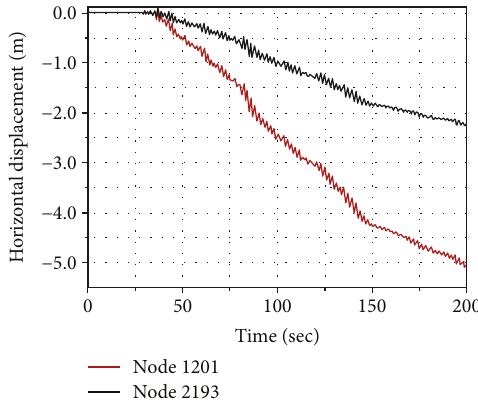
Figure 16: Time history of horizontal displacement for node 1201 and node 2193.